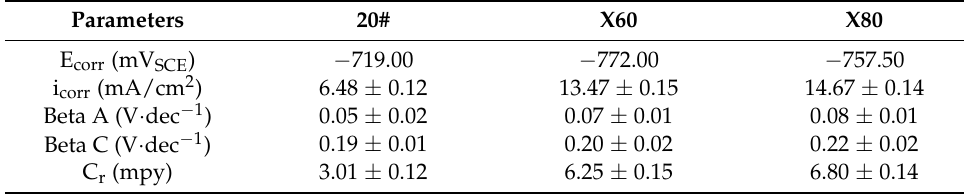
Figure 4. Polarization curve of 20#, X60, and X80 steels in NS4 solution.